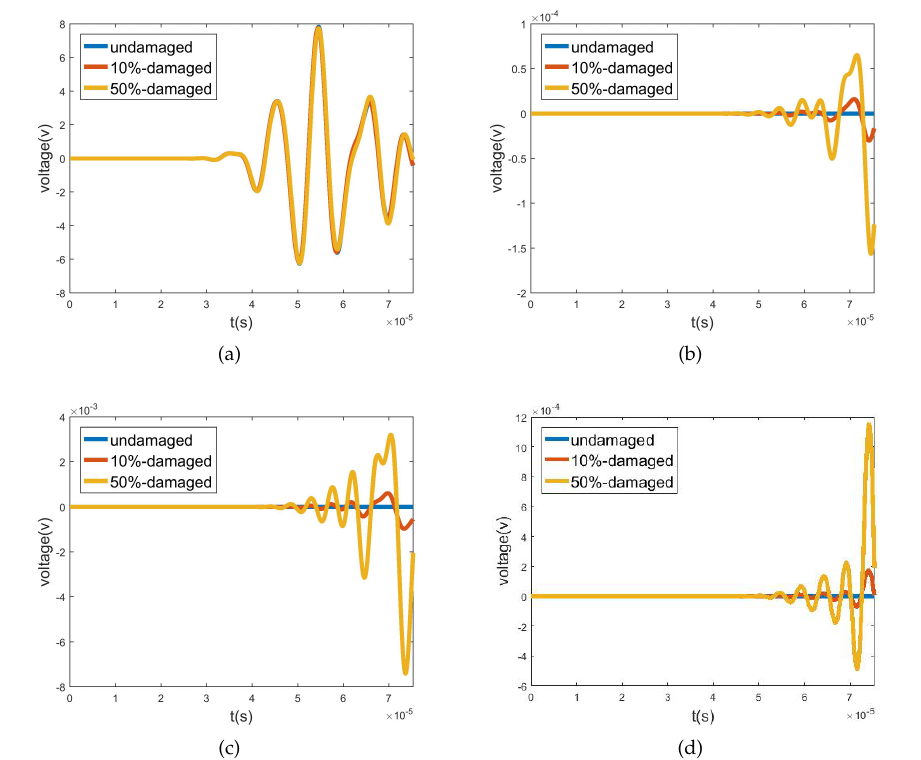
Figure 26. First verification: voltage responses of ( a ) L 0 , ( b ) T 0 , ( c ) F 6 , and ( d ) F 4 sensors excited by L 0 actuator.